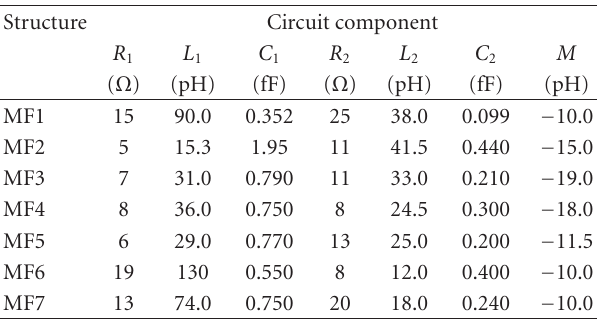
Table 2: Circuit parameters for matching TL-RLC model to sim- ulated data. Resistor values are given in Ohms, capacitor values in femtofarads, and inductor values and coupling coe ffi cients in pico- henries.